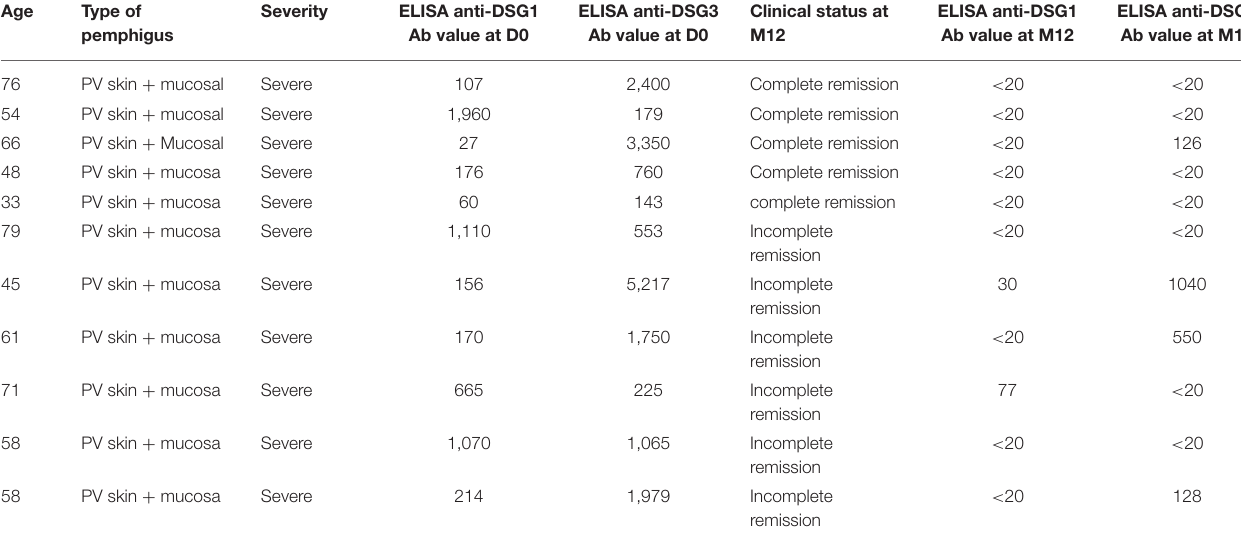
ELISA anti-DSG1 Ab value at